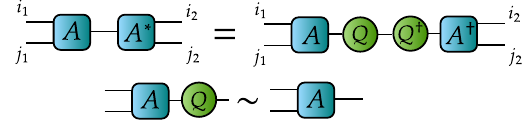
Figure 4: Diagrammatic representation of Eq. (9).